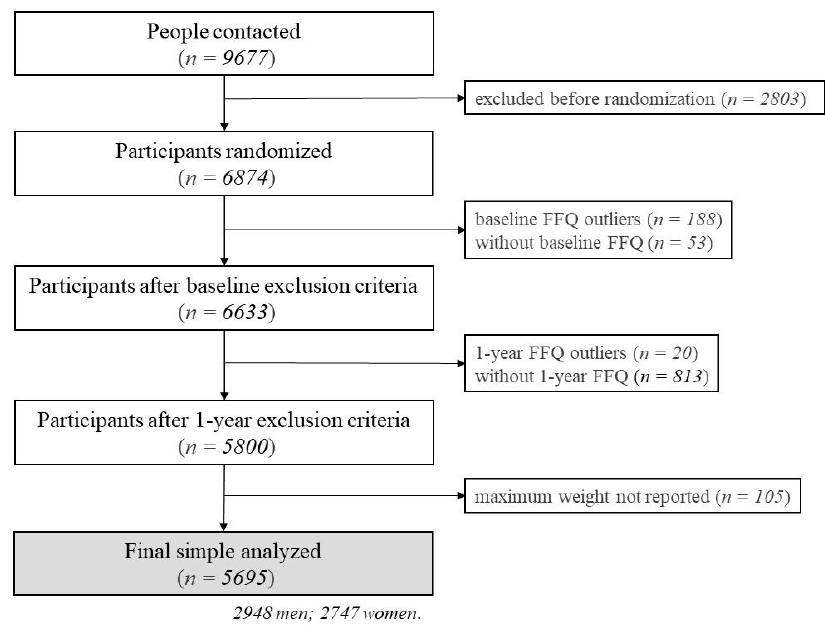
Figure 1. Flow-chart of the study participants. FFQ: food frequency